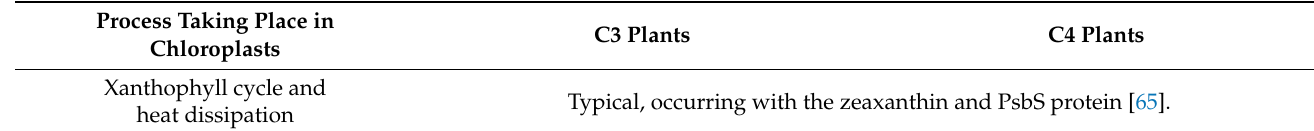
Table 1. Summary of the chloroplast processes involved in the adaptation/acclimatization of C4 plants to high light intensities, compared to C3 plants, described in the